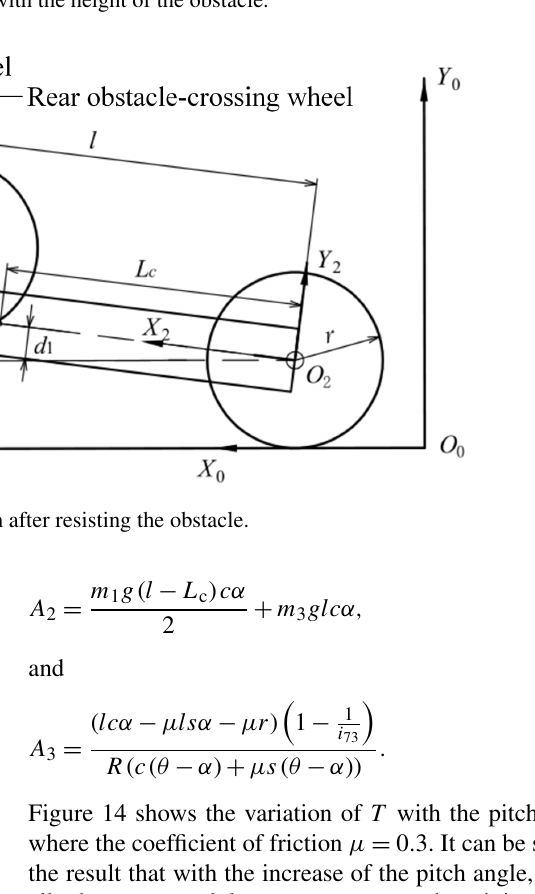
Figure 9. (a) The curves of the height of the robot’s centroid relative to initial position 0 y 0 − b 0 changing with the height of the obstacle and (b) the curves of the robot’s pitch angle α and roll angle γ changing with the height of the obstacle.